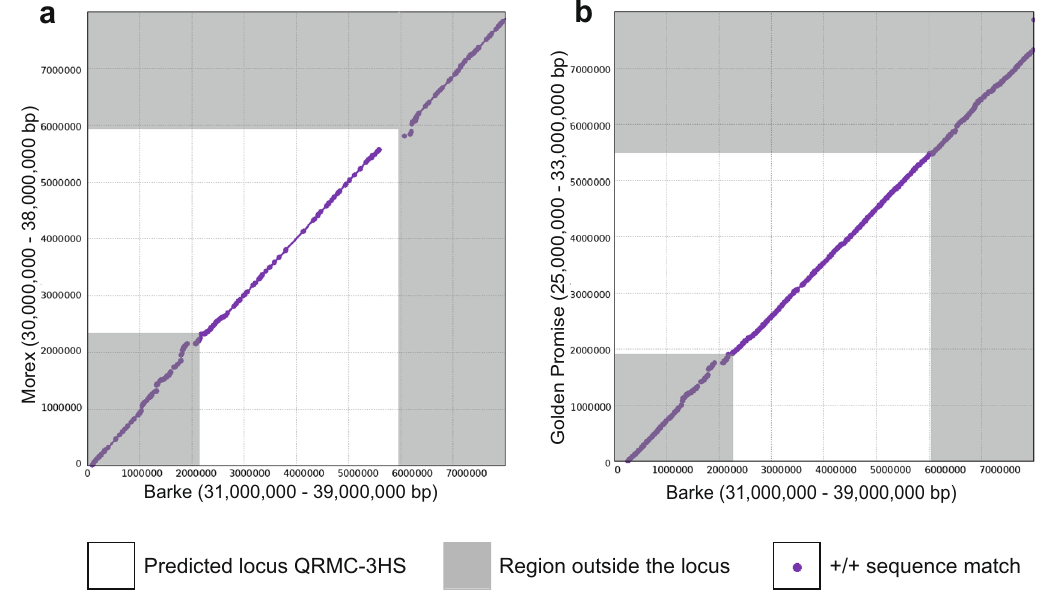
Fig. 6 Locus QRMC-3HS de fi nes an area of structural variation in the barley genome. Alignment visualisation of the sequence at and surrounding the QRMC-3HS locus comparing a the cultivars Barke and Morex and b Barke to cultivar Golden Promise. The QRMC-3HS locus is shown in white, while purple dots represent sequencing matches longer than 1000bp and ≥ 95% identity. The gap in the diagonal in ( a ) denotes a disruption of synteny between the two genotypes. Numbers on the axis denote the physical interval, in bp, analysed in the given genomes. Source data are provided as a Source data fi